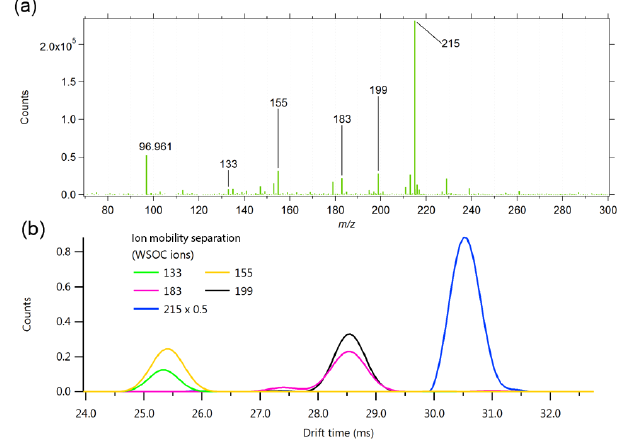
Figure 2. A typical representation of IMS–MS data in 2-D format for a SOAS filter sample (LRK site, 16 June 2013) analyzed via ESI-IMS–MS. The 2-D graph plots drift time vs. mass-to-charge ( m/z) ratio. The top mass spectrum is the total mass spectrum for all displayed drift times (20–60ms). The plot on the right is a total ion mobility spectrum for the entire displayed m/z range (50–600). The light-blue line points out an example mass mobility correlation or trend line.